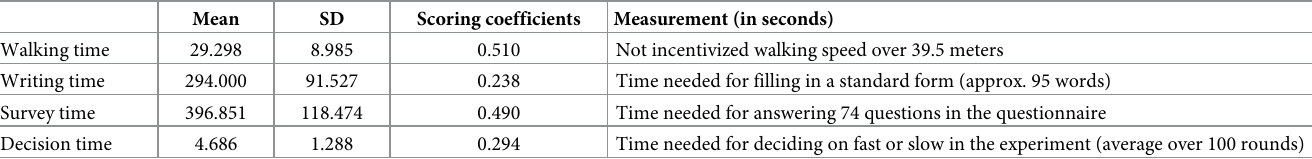
Table 2. Measures for pace of life.